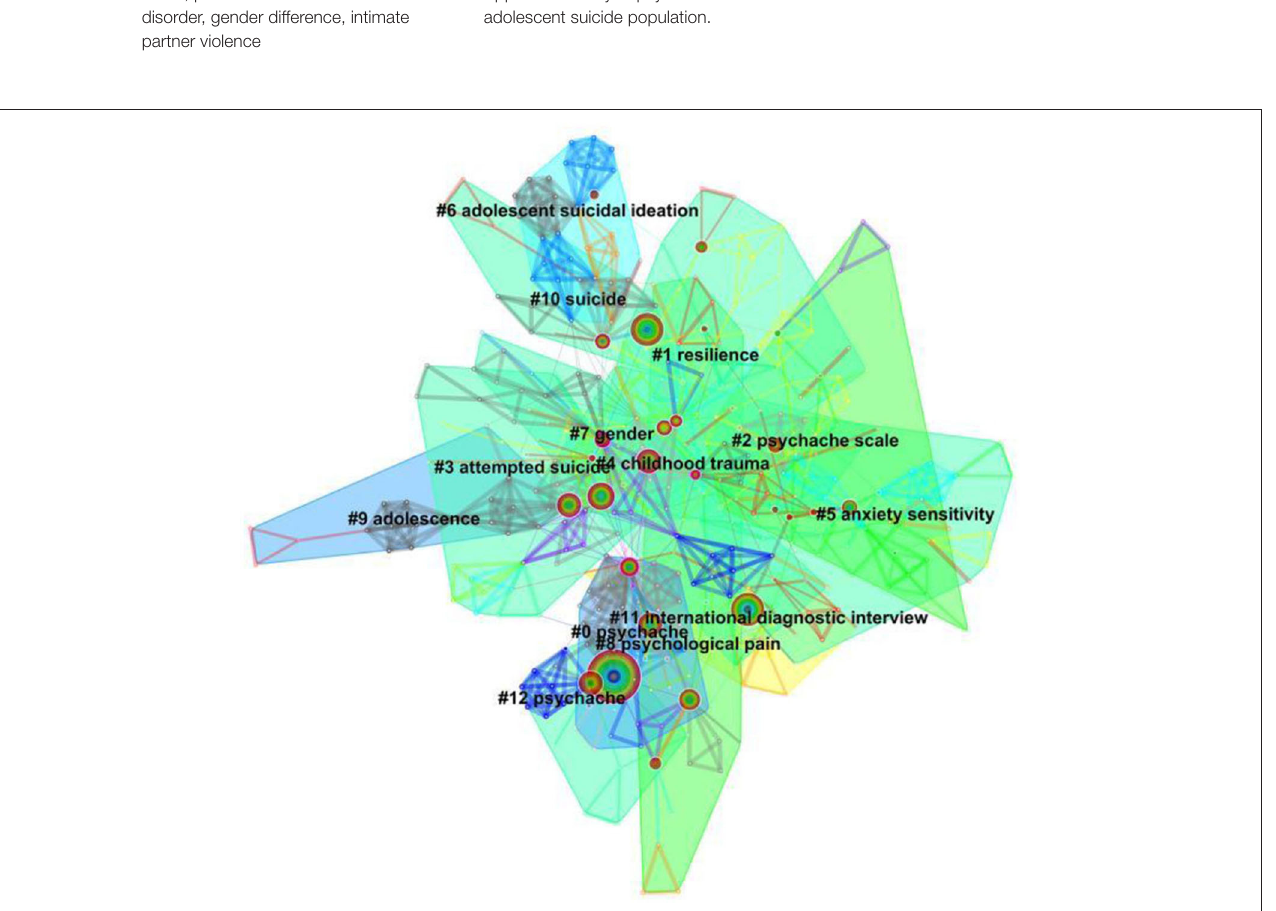
FIGURE 4 | Cluster visualization of the keywords co-citation map.